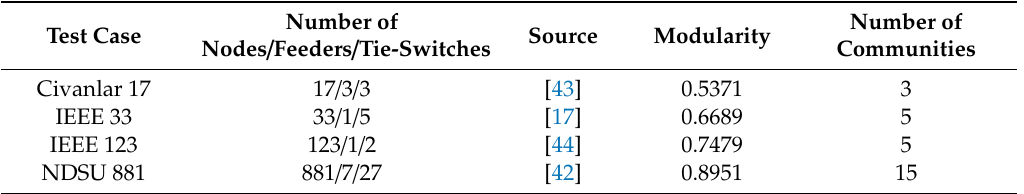
Table 2. Summary of the tested distribution grids.